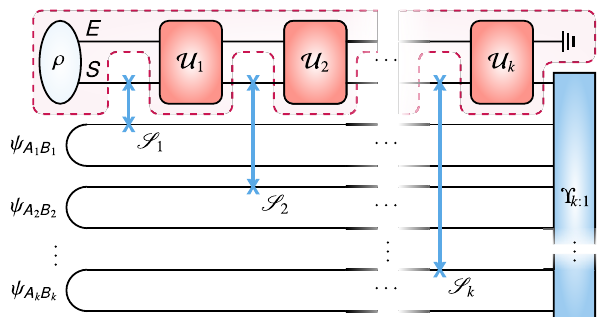
, at each step i B i